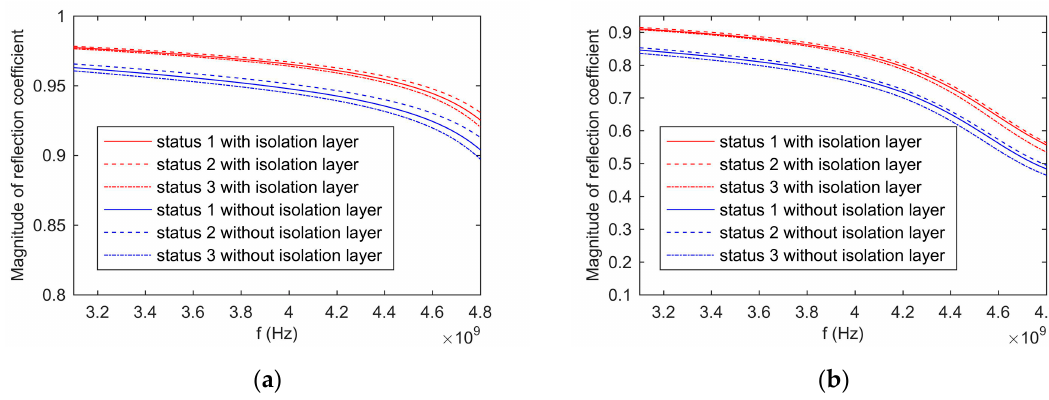
Figure 21. The magnitude of reflection coefficient: ( a ), the moisture content of wheat equals 6.2%; ( b ), the moisture content of wheat equals 18.5%.